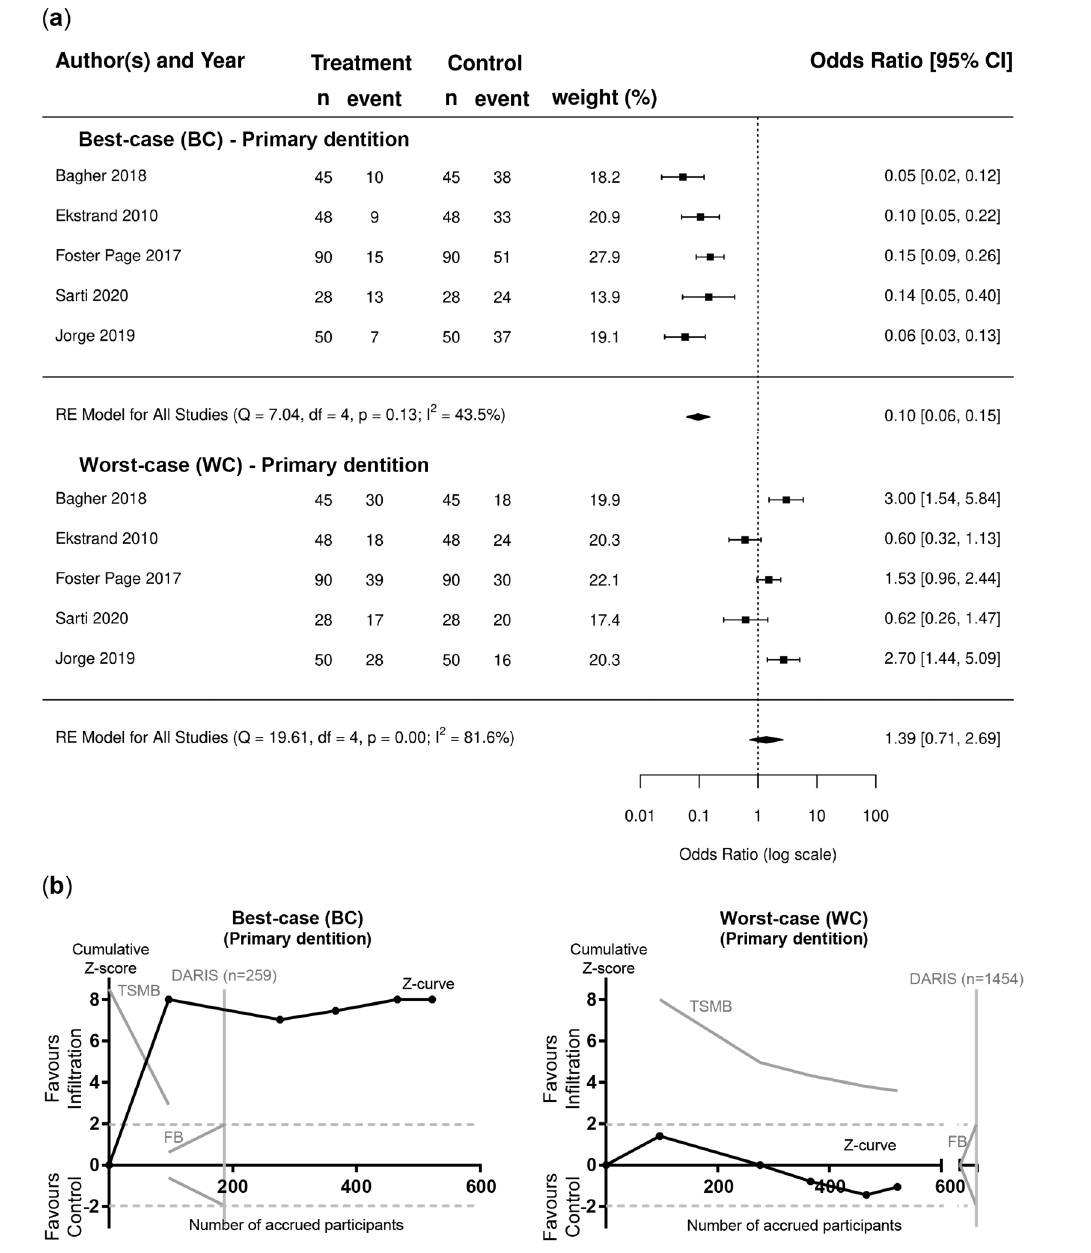
Figure 5. Primary dentition. ( a ) Forest plots of pairwise meta-analysis for BC and WC scenarios. Risk of failure, i.e., lesion progression, is indicated for lesions in primary teeth treated with resin infiltration and non-invasive measures compared to non-invasive measures alone. The odds ratio (OR) and 95% confidence intervals (CI) are shown. Heterogeneity is indicated by I 2 and Q statistics. Diamonds indicate pooled effect estimates. The number of lesions was adjusted using the design effect as described. ( b ) Trial sequential analysis (TSA) of trials evaluating lesions in primary teeth [63–67] for BC and WC scenarios to assess the robustness of evidence. The cumulative Z-score (black curve), i.e., the accumulated level of significance, was plotted against the number of participants accrued so far, which was compared with the heterogeneity-adjusted required information size (DARIS), the conventional border (Z = 1.96), the trial sequential monitoring boundary (TSMB), and the futility border (FB) (grey oblique). For the BC scenarios, the Z-curve crossed the conventional border and TSMB before reaching DARIS, whereas for the WC scenario, the Z-curve failed to cross the conventional border, TSMB, and DARIS.